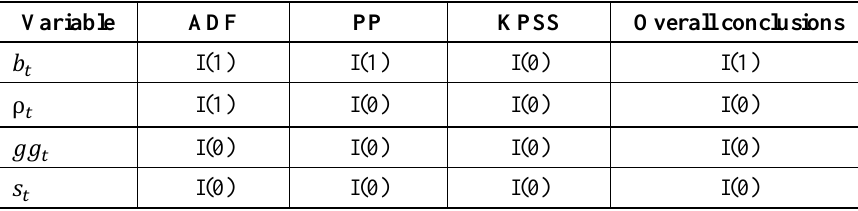
Table 3. Conclusions of the stationary